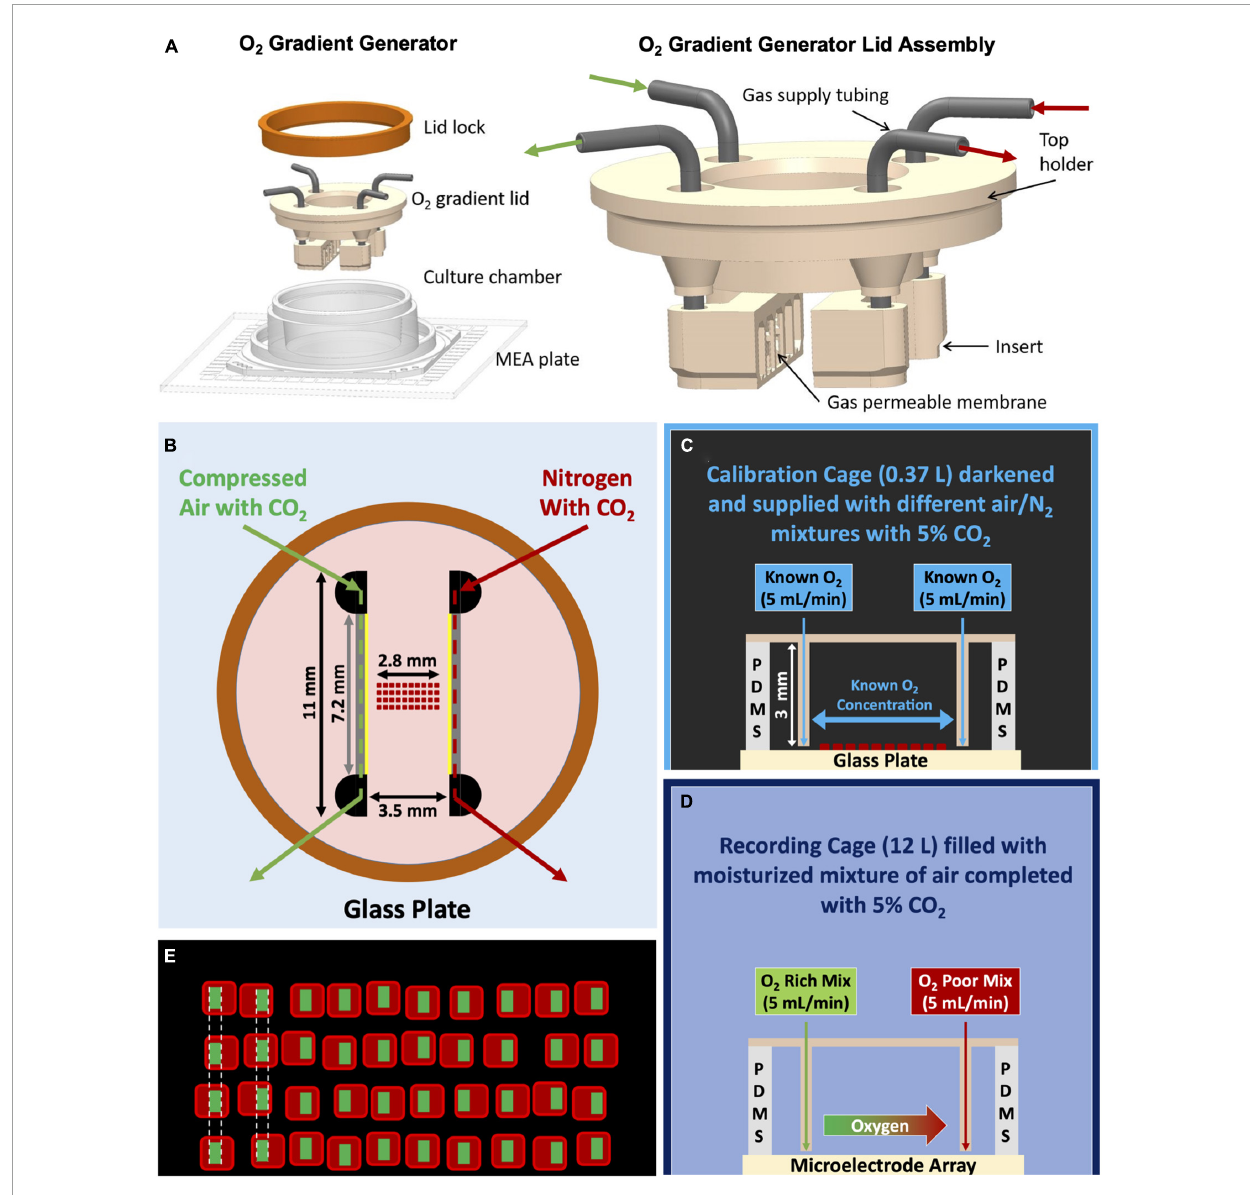
FIGURE1 Various schematics of the oxygen gradient generator and the setup. (A) 3D model of the device. After closing the top of the culture well (MEA with the culture chamber) with the gradient lid, it is sealed with the lid lock (orange ring). The lid assembly (on the right) consist of a top holder, two inserts and 19G stainless-steel connectors. The inserts are facing each other and each one has attached a gas permeable silicone membrane. (B) Top view of the device sealed with the ring, indicating the dimensions of the device and the placement of the oxygen sensors grid. Membranes through which gas exchange takes place (7.2 × 3 mm) are indicated in yellow. The lower border of the membranes was ∼ 0.2 mm above the surface of the MEA. (C) Representation of the complete setup for calibration with the calibration cage (smaller and darkened), the grid of sensors which was exposed to gas mixtures of known O 2 concentrations, and a cross-sectional view of the glass plate, silicone culture chamber and lid assembly. (D) Representation of the complete setup for cell experiments in the recording cage (bigger and not darkened), the gas mixtures supplied to the generator (green: compressed air with CO 2 ; red: N 2 with CO 2 ), and a cross-sectional view of the MEA, silicone culture chamber and lid assembly. (E) Representation of the grid of sensors and the definition of the ROIs for the calculation of the red phosphorescence intensity and estimation of oxygen